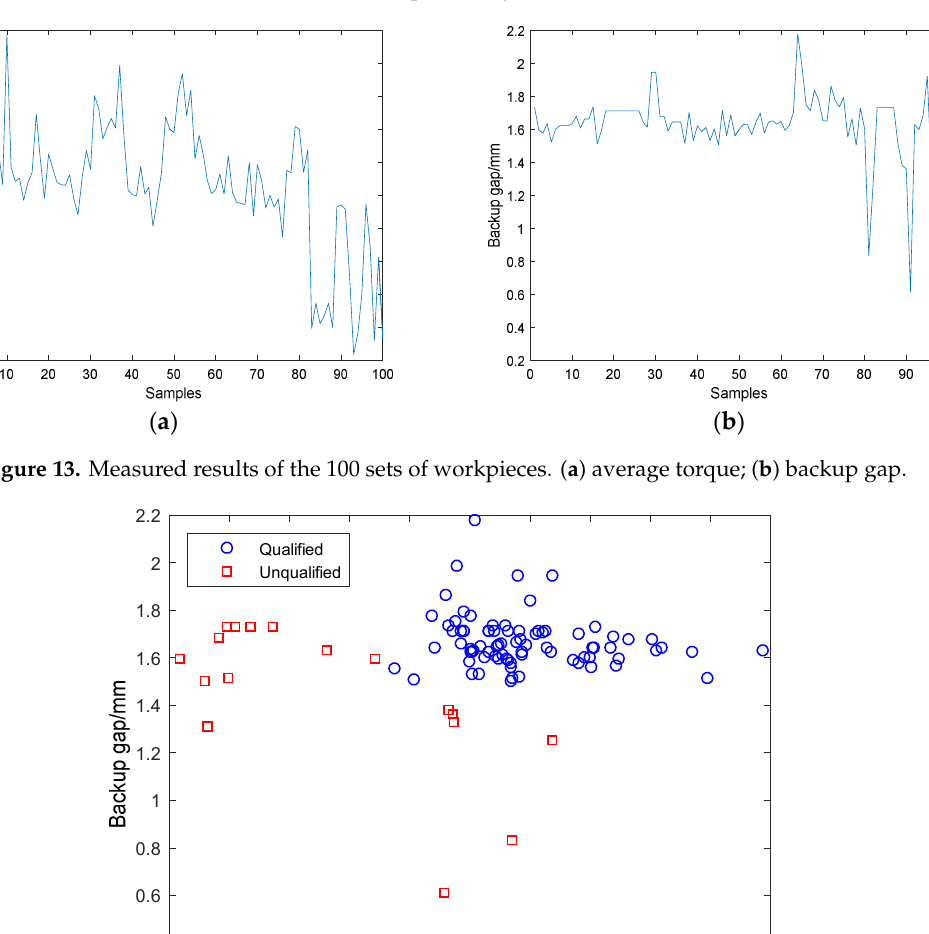
Figure 13. Measured results of the 100 sets of workpieces. ( a ) average torque; ( b ) backup gap.